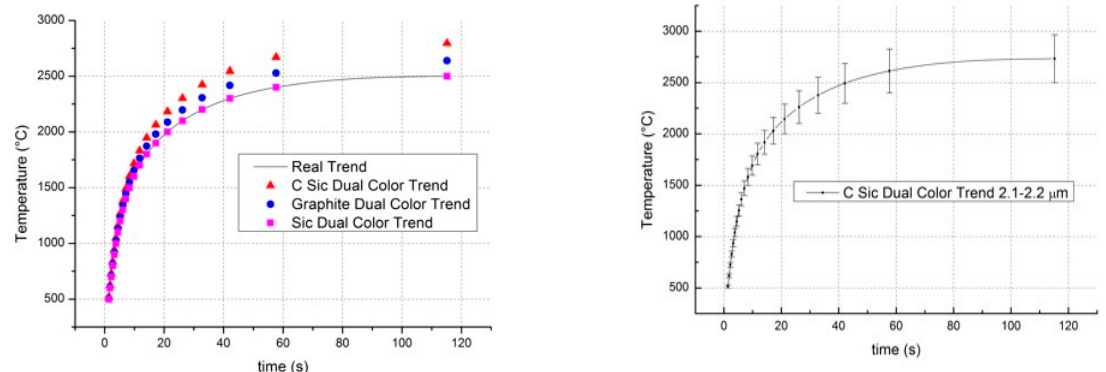
Figure 11. Trend of temperature measured with DC technique for different materials is shown on the ( left ), and DC temperature trend for C/SiC material including error bars is shown on the ( right ).